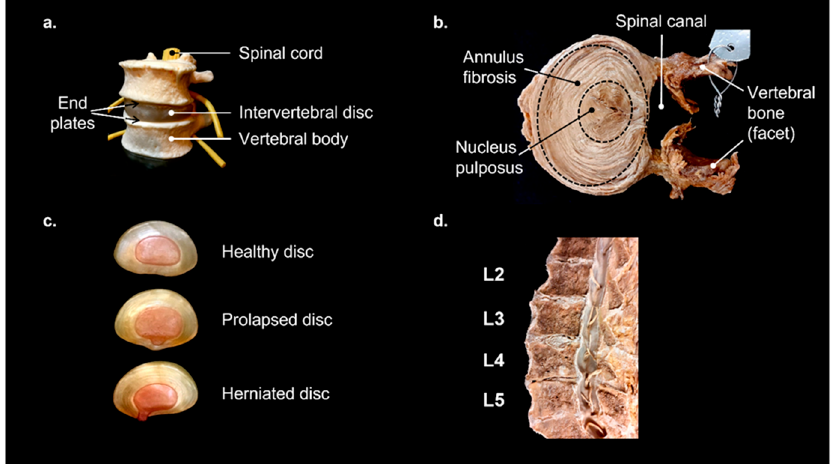
Figure 2. Intervertebral discs. ( a ) Model showing intervertebral disc between two adjacent vertebrae, nerves and spinal cord shown in yellow. ( b ) Transverse section through a human intervertebral disc showing the lamellae of the annulus fibrosis and the central nucleus pulposus. ( c ) Transverse section models of progression of intervertebral disc degeneration, from healthy to prolapsed to herniated. ( d ) Sagittal section of lumbar region of human spine, with vertebrae labelled. The nucleus pulposus of the L3/L4 disc is clearly visible as a white oval structure. However, the disc between L4 and L5 is severely degenerated resulting in vertebral bodies in direct contact with one another. Sections were from a 78-year-old female prepared using material from the University of Otago, Anatomy Museum.